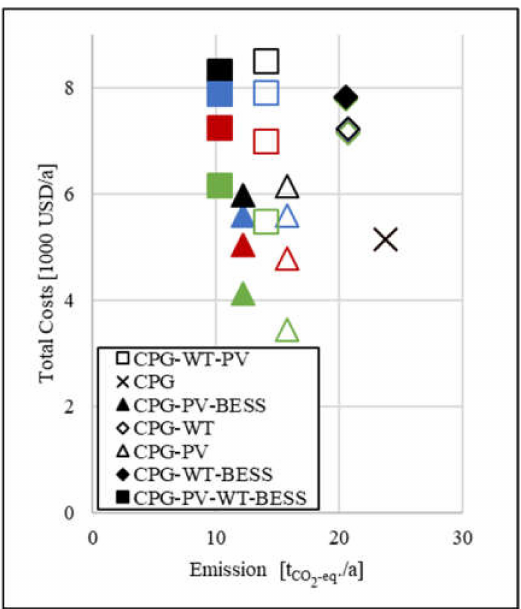
Figure 7. Economic and ecological impact of RES with no (black), 0.02 USD/kWh (blue), 0.05 USD/kWh (red), and 0.1 USD/kWh (green) FIT based on the NESSI4D